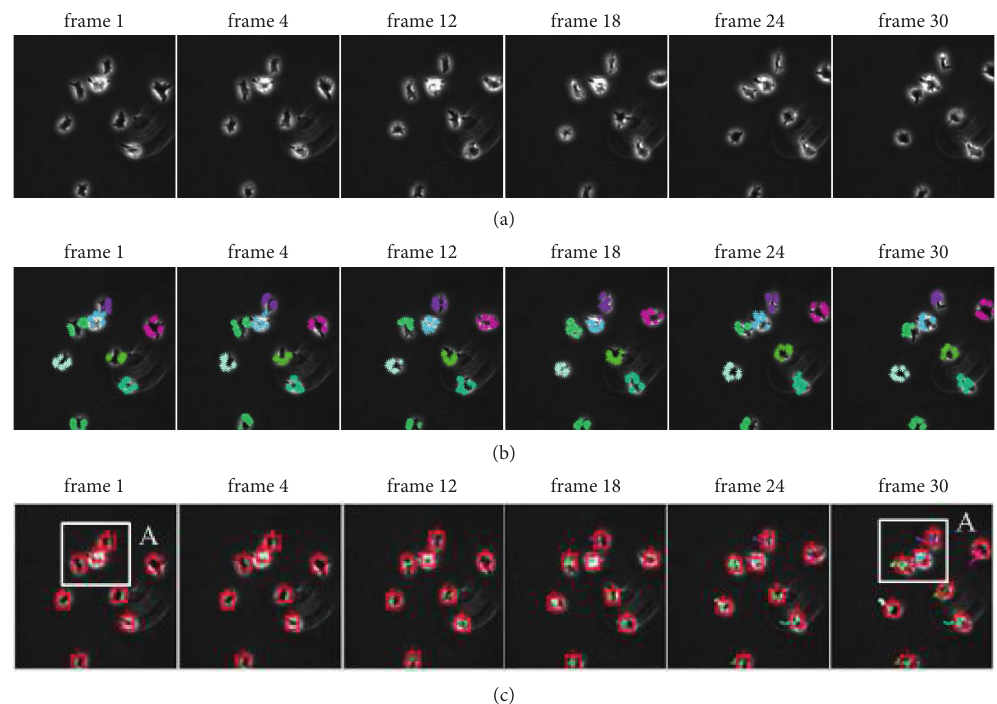
Figure 8: Tracking results with our proposed algorithm in different frames. (a) Original RGB image. (b) Results of ant distribution in different frames. (c) Tracking partial results of original RGB image